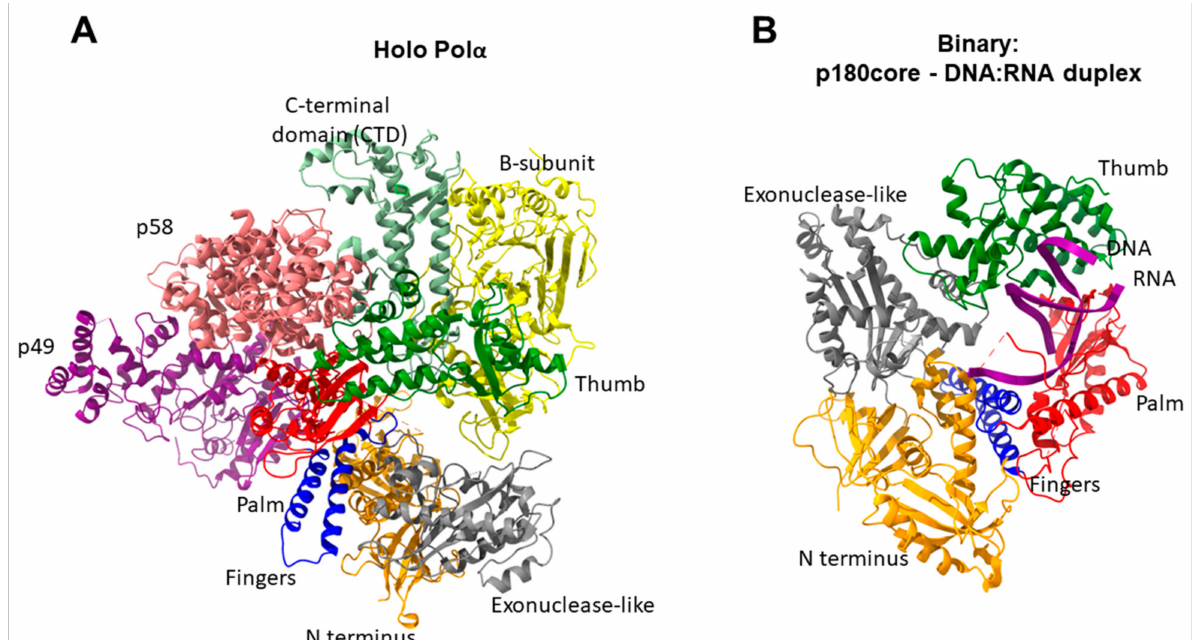
Figure 4. Three-dimensional structure of ( A ) the holo Pol α with primase (PDB ID 5exr), and ( B ) binary complex of catalytic subunit p180core with DNA–RNA duplex (PDB ID 4q5v). Pol α is composed of two polypeptides: the catalytic subunit (p180) and the accessory B-subunit (p70). p180 contains two domains, the catalytic (p180core) and the C-terminal (CTD, light green) domains. CTD connects the catalytic domain with B-subunit and primase, and contains two conserved zinc-binding modules. The p180core consists of five subdomains: N-terminal (orange), thumb (green), palm (red), fingers (blue) and exonuclease-like (gray) domains. DNA–RNA duplex is dark magenta. The N terminus of p180 is predicted to be poorly folded and does not participate in primer synthesis. Human primase consists of catalytic (p49, purple) and regulatory (p58, pink)